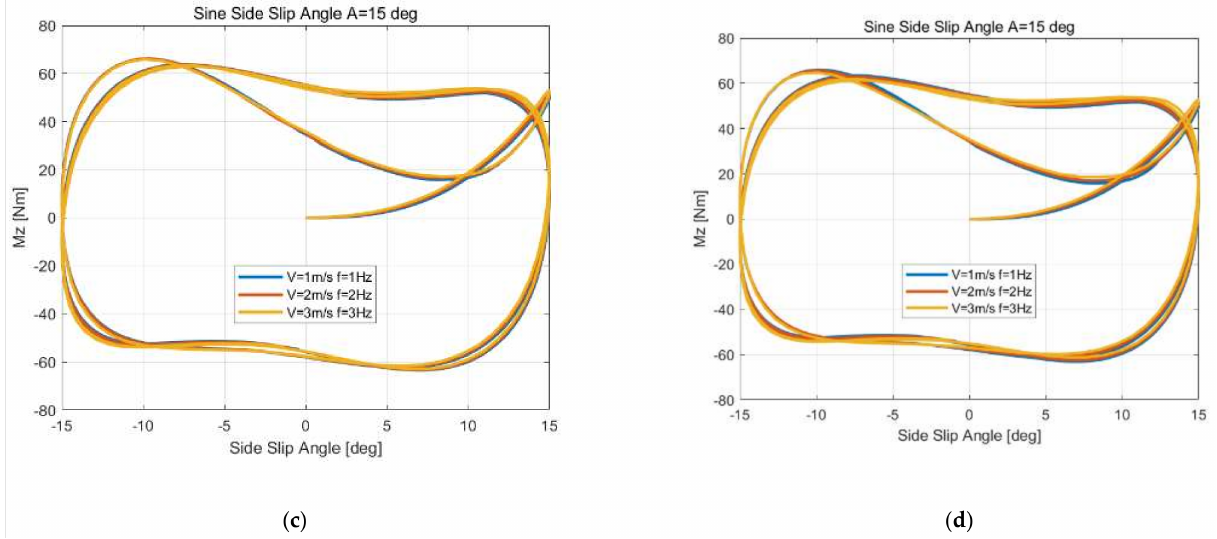
Figure 13. Response of lateral force and aligning moment under sine side slip angle input. ( a ) Re- sponse of lateral force using the proposed method. ( b ) Response of lateral force using the reference method. ( c ) Response of aligning moment using the proposed method. ( d ) Response of aligning moment using the reference method.